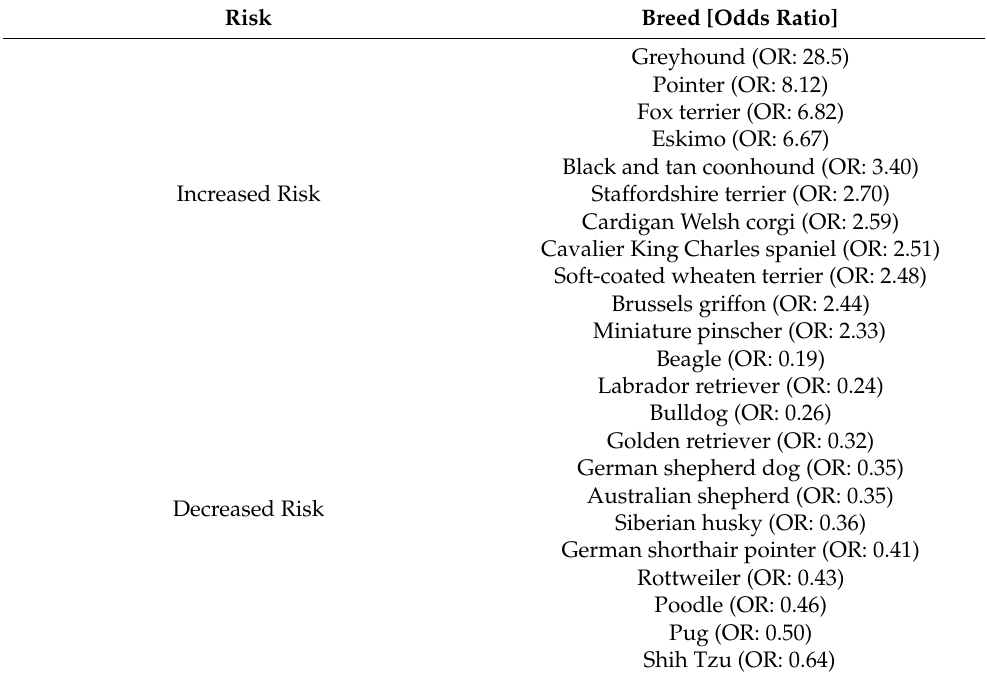
Table 2. Breeds with a statistically significant increase or decrease in risk for an increased serum cPLI concentration. Risk Breed [Odds Ratio] Greyhound (OR: 28.5)